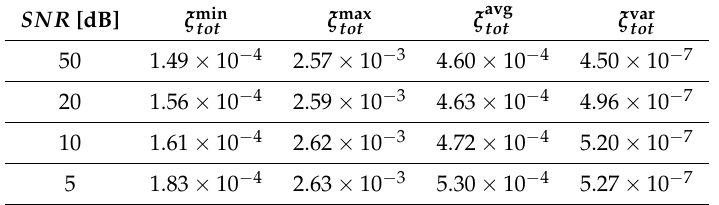
Table 2. Numerical Assessment ( K = 2, O = 2, τ = 1.0, W = 100, MT-BCS )—Total error